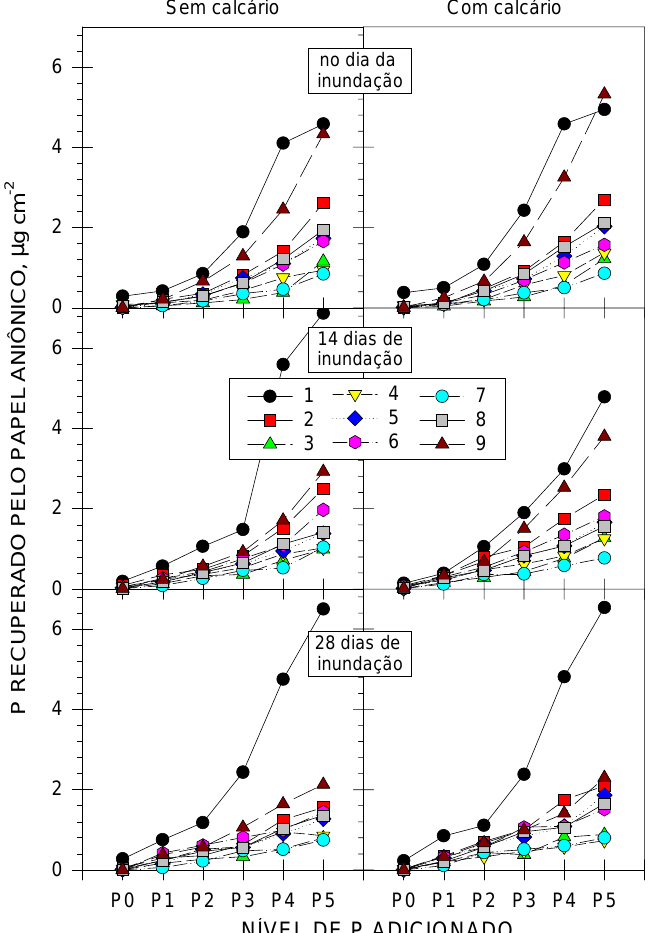
Figura 2. Fósforo recuperado pelo papel aniônico em amostras de nove solos de várzeas, submetidos a seis doses de fósforo na presença e ausência de calcário, considerando diferentes períodos de